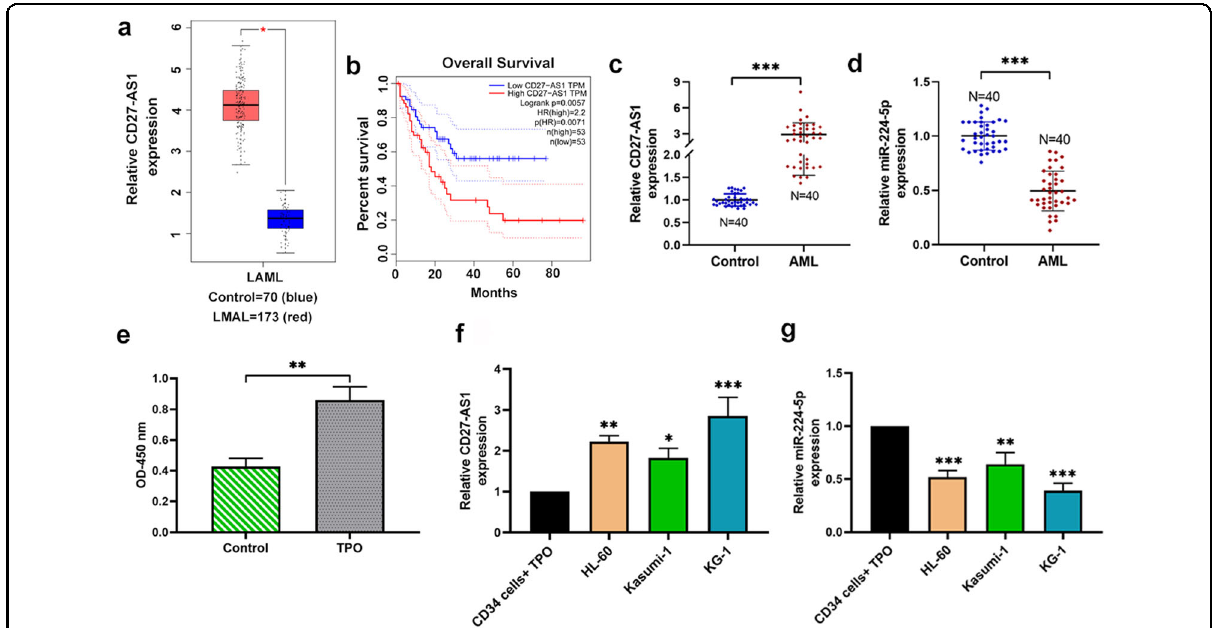
Fig. 1 CD27-AS is overexpressed in AML samples and cell lines and is negatively corrected with the prognosis of AML patients. a , b Expression levels of CD27-AS1 in AML patient samples and the relationship between CD27-AS1 expression and prognosis of AML patients analyzed by the Cancer Genome Atlas and the Genotype-Tissue Expression databases. c , d Relative expression levels of CD27-AS1 and miR-224-5p in bone marrow mononuclear cells of AML patients ( N = 40) and healthy volunteers ( N = 40). e The viability of normal CD34 + cells treated with recombinant human TPO (hTPO) (10 ng/mL) was detected by CCK-8 assay. f , g Expression levels of CD27-AS1 and miR-224-5p in the TPO-treated CD34 + cells and AML cell lines (HL-60, Kasumi-1, KG-1) were detected using qRT-PCR. N = 3. Data were shown as means ± SD. * P < 0.05, ** P < 0.01, and *** P <